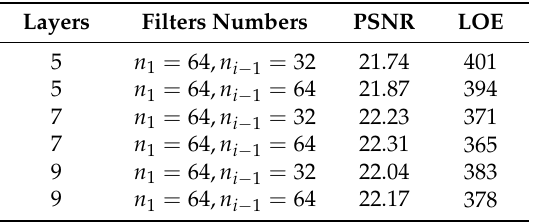
Table 1. PSNR of different network layers and filters